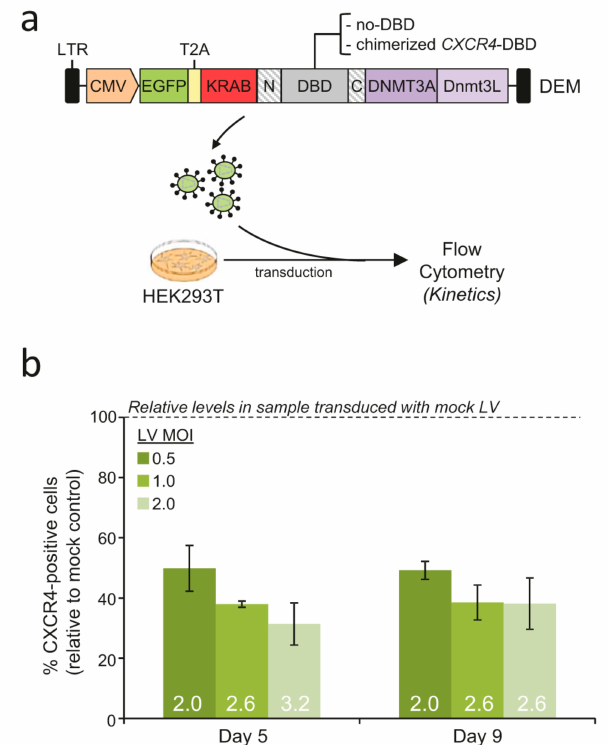
Figure 3. Lentiviral delivery of chimerized designer epigenome modifiers (DEMs). ( a ) Schematic